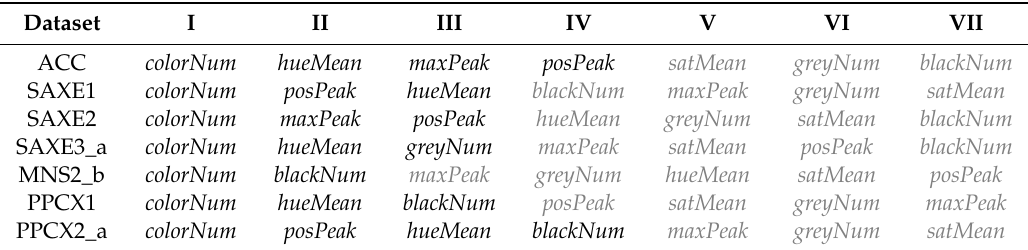
Table 4. Order of features identified during cross-validation analysis for each dataset; features in black are those selected for classification.